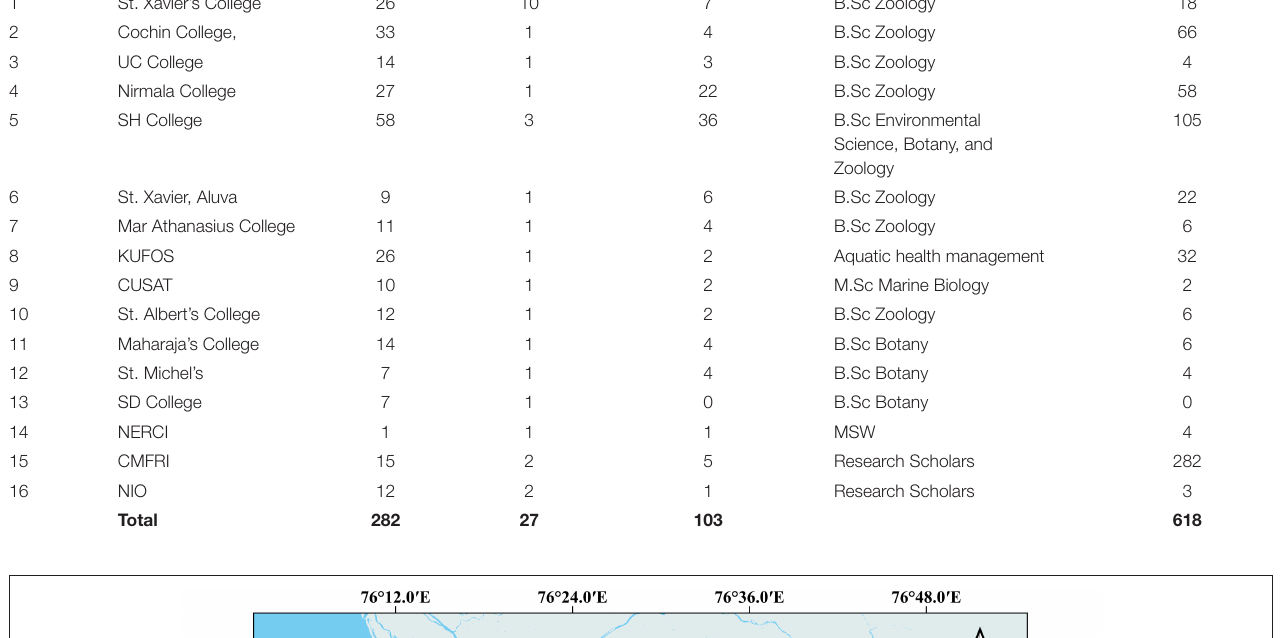
TABLE 1 | Activity summary of the colleges along the vicinity of the lake who participated in the citizen science programmes. Sl. No.